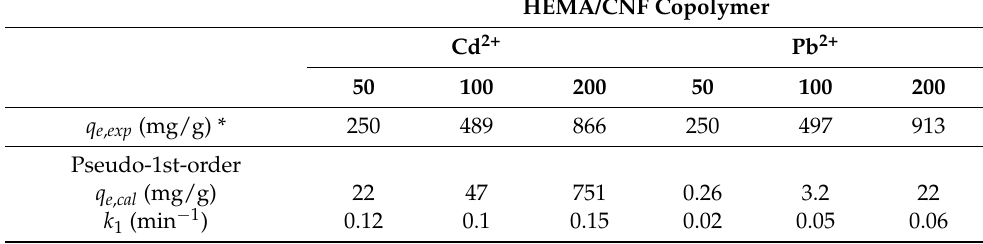
Table 1. Parameters and determination coefficients of the kinetic models for Cd 2+ and Pb 2+ adsorption on prepared HEMA/CNF